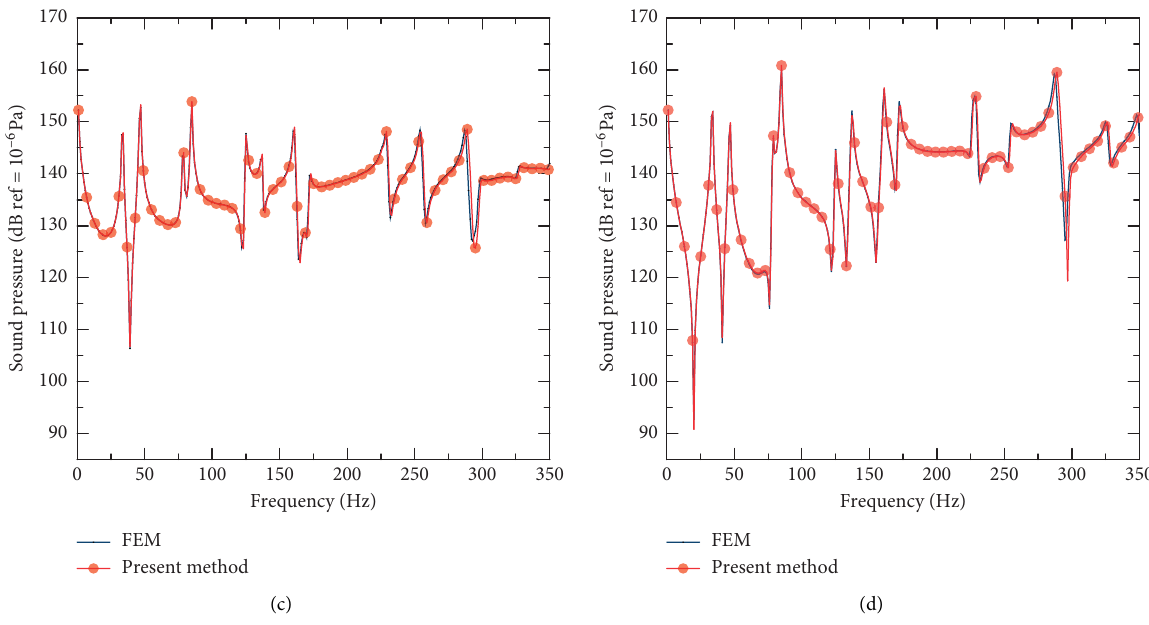
Figure 6: Response under internal point acoustic source excitation. (a) Velocity response at (0.10, 0.12, 0.14). (b) Velocity response at (0.15, 0.30, 0.14). (c) Sound pressure response at (0.08, 0.11, 0.07). (d) Sound pressure response at (0.20, 0.33,